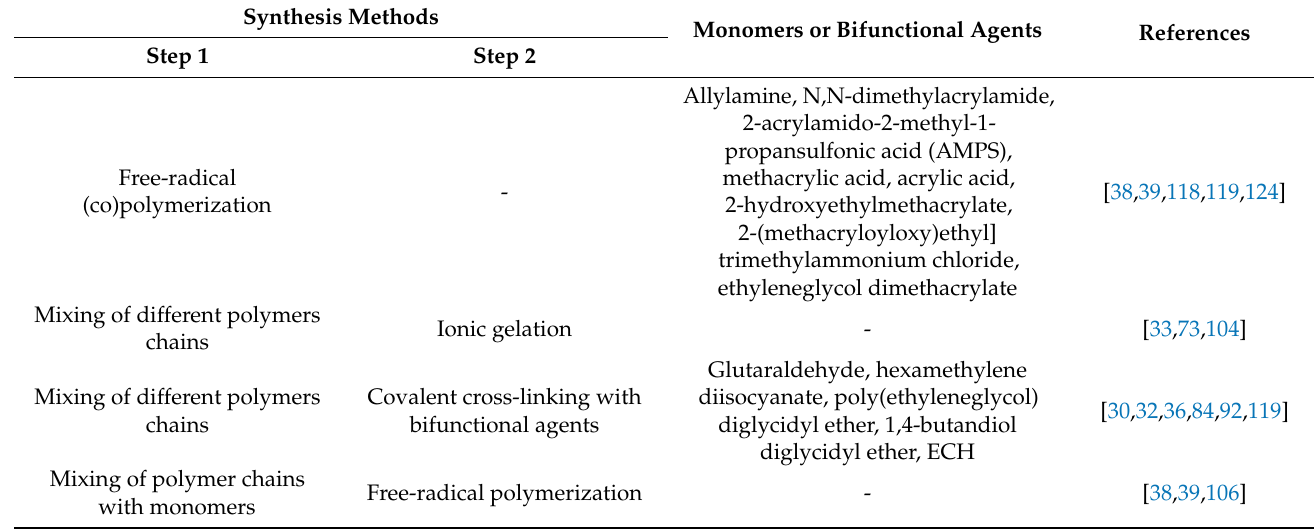
Table 2. Synthesis methods of gel composites sorbents.